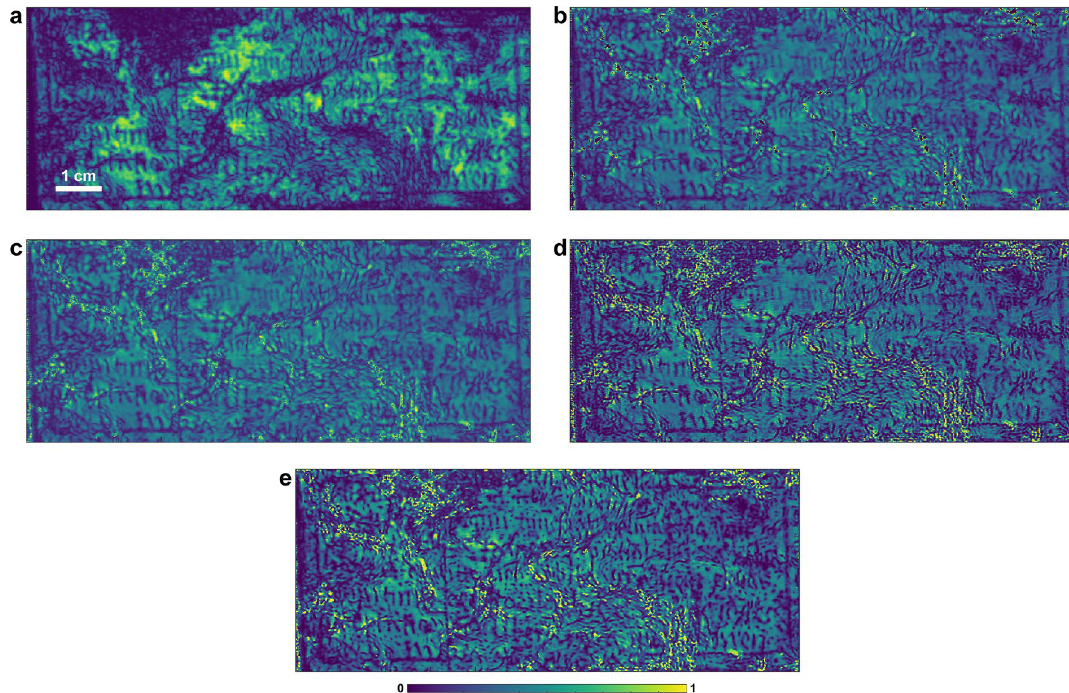
Figure 4. The output images from each step of the post-processing chain. ( a ) The input image R in ( x , y ) . ( b ) The image after intensity correction. ( c ) The image after inpainting. ( d ) The image after blind deconvolution. ( e ) The image after contrast enhancement. All the images are normalized to their maximum pixel